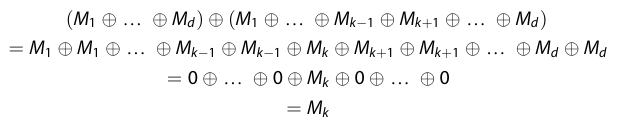
DNA synthesis and sequencing, but previous work has focused only on partially encoded GC content. In the adaptive coding algorithm for non- payload bits proposed in this paper, the GC content threshold during non- payload coding can be set in the DNA storage system based on the GC content encoded in the payload bits, which is calculated as in Eq. (10). The table of lower bounds for the set of non-payload encoding under different constraints is given in Supplementary Table 4.